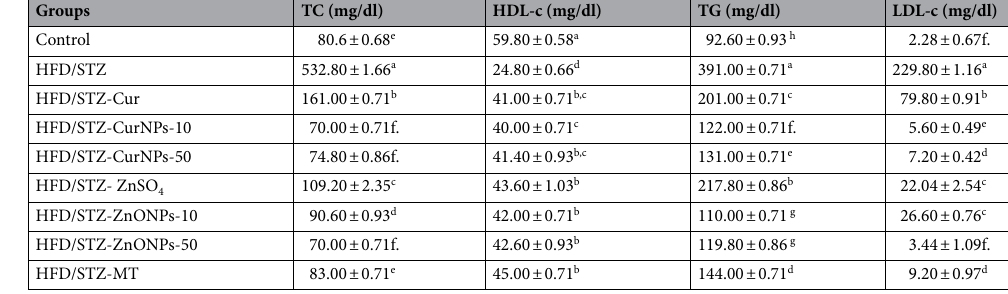
Table 3. Effect of CurNPs and ZnONPs administration on serum lipid profile TC, TG, HDL-c and LDL levels of STZ-induced diabetic and control rats. Values are expressed as mean ± SEM (n = 7), means for the same parameter with different letters in each column are significantly different (Tukey, p < 0.01).